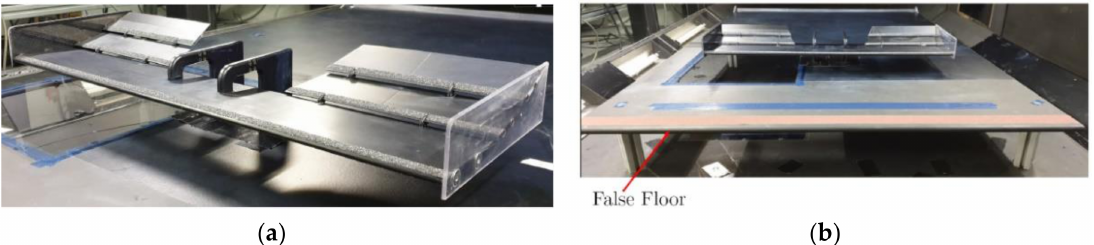
Figure 1. An image of the experimental setup. ( a ) Wing geometry; ( b ) False floor. The wing consisted of a three-element, part-span flap design with flat endplates. The main-element is a NACA2412 profile with a chord length of 130 mm and an angle of incidence of 0 ◦ . Each flap is a Göttingen 795 profile with a chord length of 75 mm and an angle of incidence of 13 ◦ and 22 ◦ degrees respectively concerning the upstream and downstream flaps. The total chord length, c, is 270 mm with consideration of a 5 mm element overlap. The wingspan is 820 mm. Additional components such as the swan-neck mounts were required to connect the wing to the force-balance whilst small supports were attached between the wing elements to minimise aerodynamic